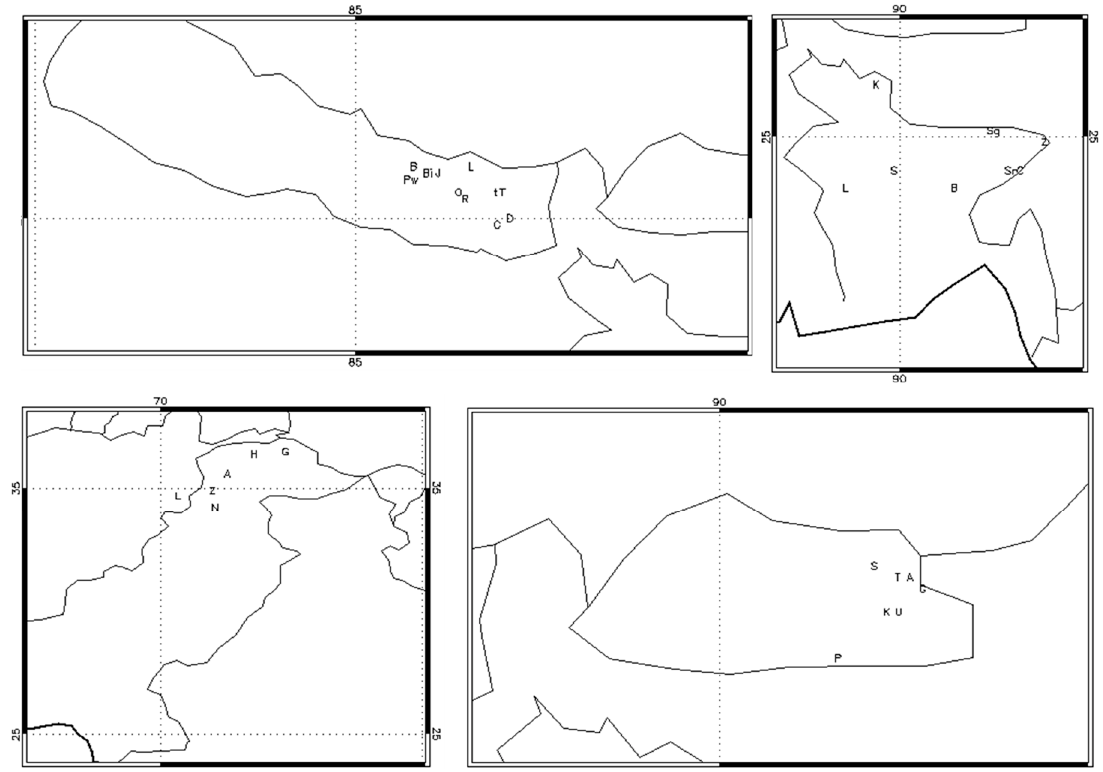
Figure 4. The location of stations providing observational precipitation data from ( top left ) Nepal: B = Bahrabise, Bi = Busti, C = Chatara, D = Dhankuta, J = Jiri, L = Lukla, O = Okhaldhunga, Pw = Pachuwarghat, R = Rabuwabazar, T = Tumlingtar, t = Turkeghat, ( top right ) Bangladesh: B = Bhairab Bazar, C = Chatlaghat, K = Kurigram, L = Lalan Shah Bridge, S = Sirajganj, Sr = Srimangal, Sg = Sunamgunj, Z = Zakigunj, ( bottom left ) Pakistan: H = AWS-Gupis, A = AWS-Kalam, G = Ganish Bridge, H = HS-Gupis, A = HS-Kalam, L = Lower Dir, N = Nowshera, Z = Zulam and ( bottom right ) Bhutan: A = AWS-Trashi Yangtse, G = Gongrichu, K = Korilla, P = Pangbang, S = Sumpa, T = Trashi Yangtse, and U = Uzorong.